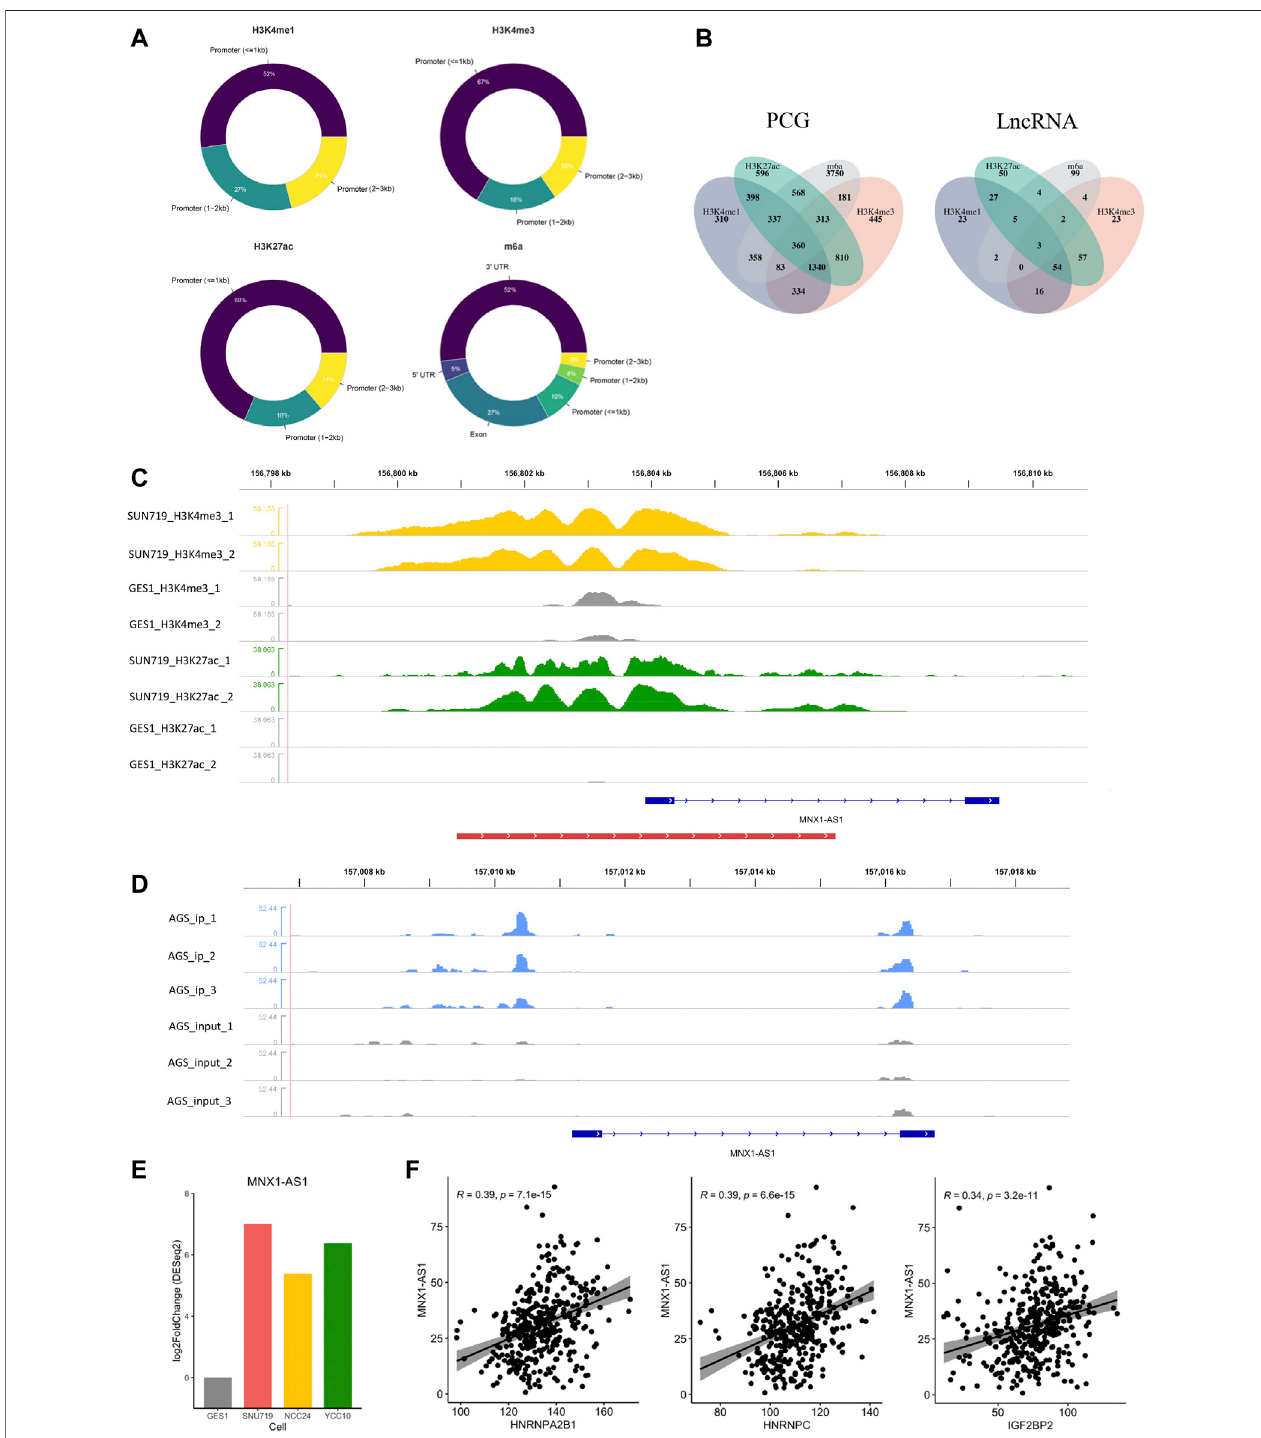
FIGURE 3 | Identi fi cation of epigenetic modi fi cation-related LncRNA (EMRL). (A) Doughnut charts showed the distribution of DHMS or MMS in each modi fi cation type. (B) VenndiagramshowedtheoverlapsofEMRG(orEMRL)regulatedbydifferentmodi fi cationtypes.PCGreferstotheprotein-codinggenes,andLncRNArefersto the long non-coding RNAs. (C) MNX1-AS1 was potentially regulated by H3K4me3 and H3K27ac in GC cell lines. Peaks in yellow and green refer to H3K4me3 and H3K27ac, respectively, while gray ones refer to the corresponding modi fi cation in GES-1 as control. The red line at the bottom refers to the promoter region. (D) m6A modi fi cation regions of MNX1-AS1 in the AGS cell line. Peaks in blue refer to the immunoprecipitation (IP) signals. Peaks in gray refer to the input signals. (E) DifferentialexpressionofMNX1-AS1inGCcelllinesandGES-1( p < 0.05). (F) CorrelationsofMNX1-AS1withthem6AregulatorsincludingHNRNPC,HNRNPA2B1,and IGF2BP2 (Spearman, p <